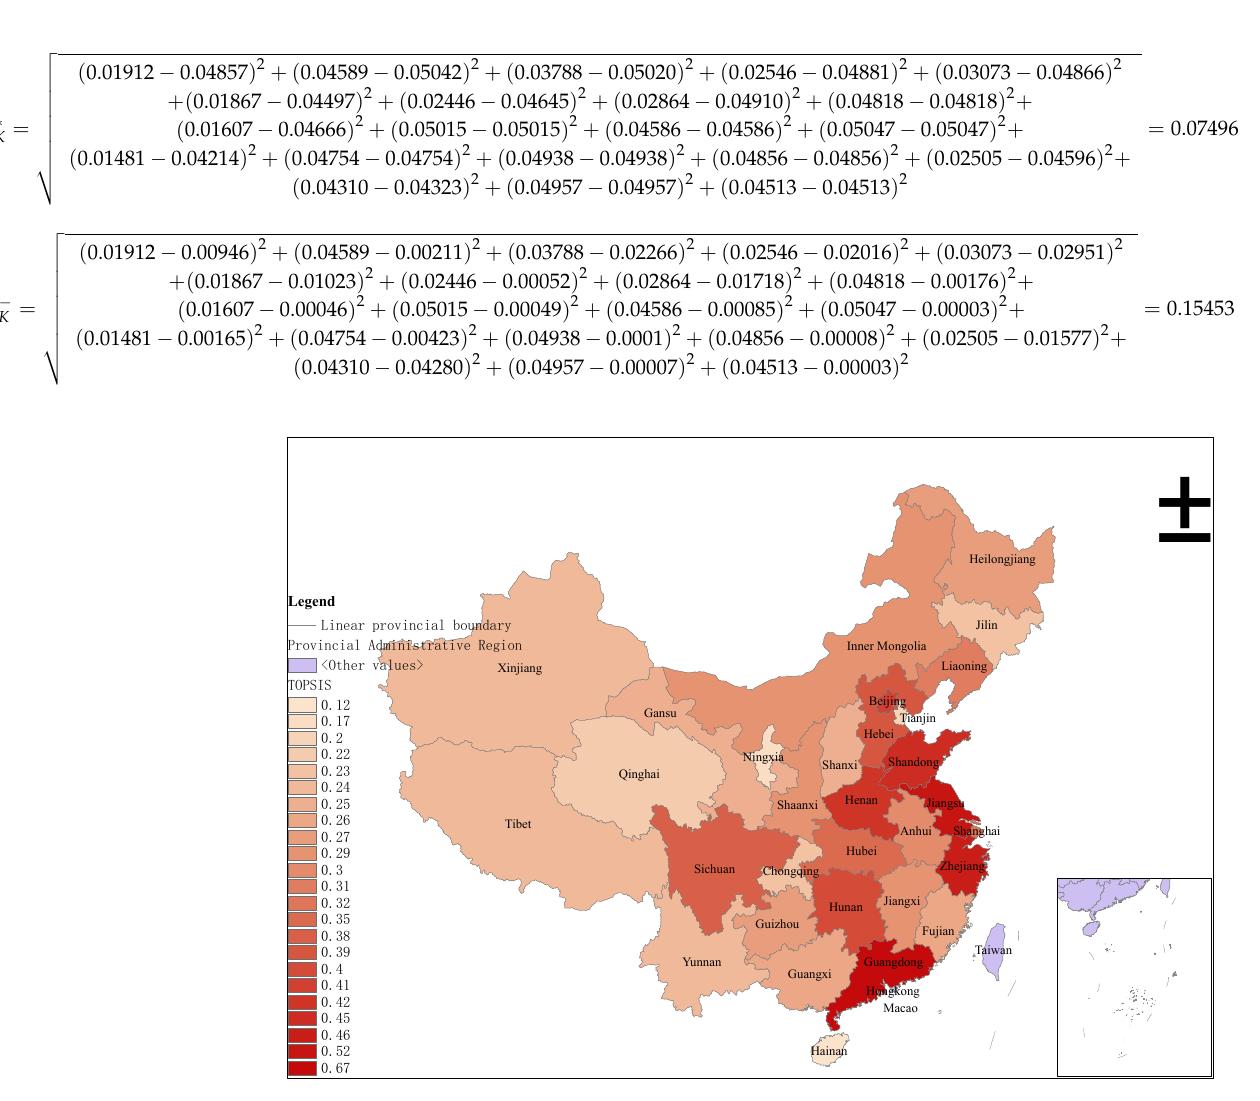
Figure 2. TOPSIS results by province in China.